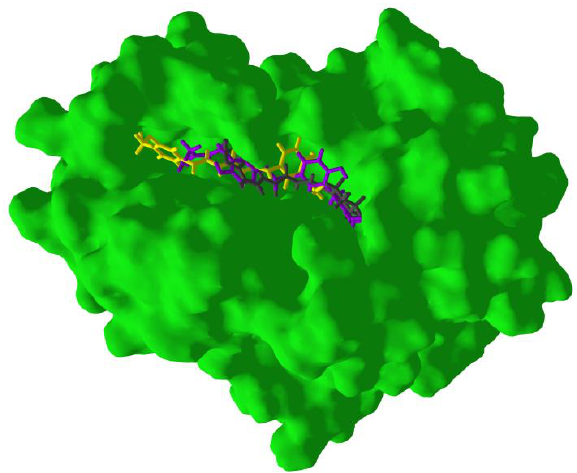
Figure 12. Lowest-energy docked poses of 2 ′ ,4,4 ′ -trihydroxy-3,3 ′ -diprenylchalcone (magenta), curcumin (yellow) and piperine (black) with Trichomonas vaginalis purine nucleoside phosphorylase (TvPNP).